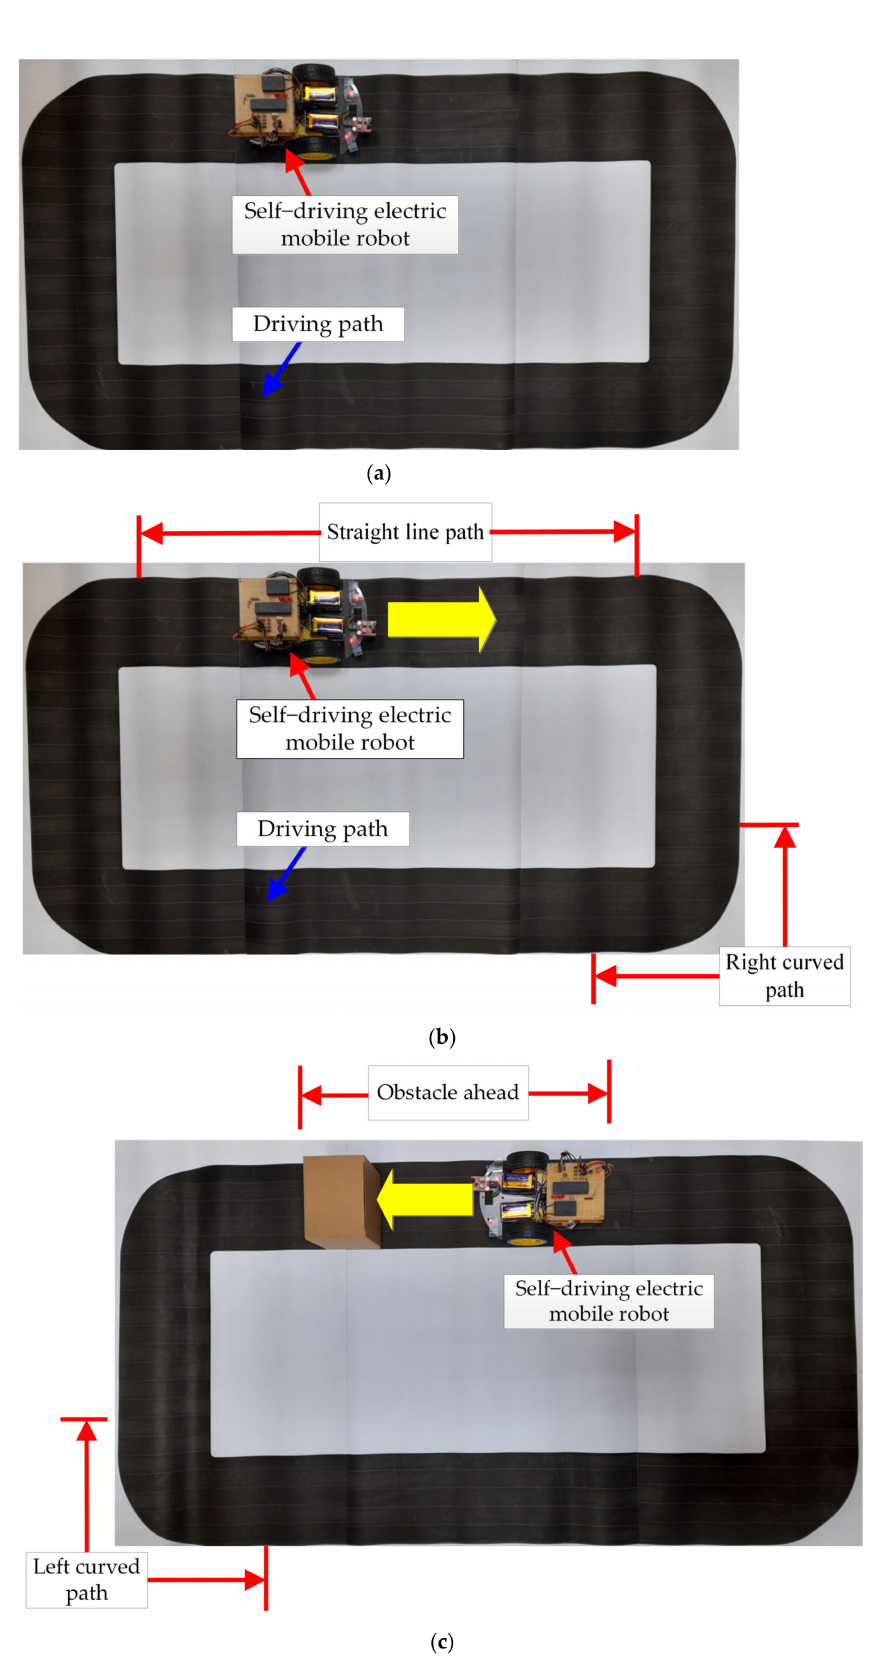
Figure 11. Stereogram of the self-driving electric mobile robot and driving path: ( a ) overall view, ( b ) schematic diagram of a straight line path and right turn, and ( c ) schematic diagram of an obstacle ahead and the left